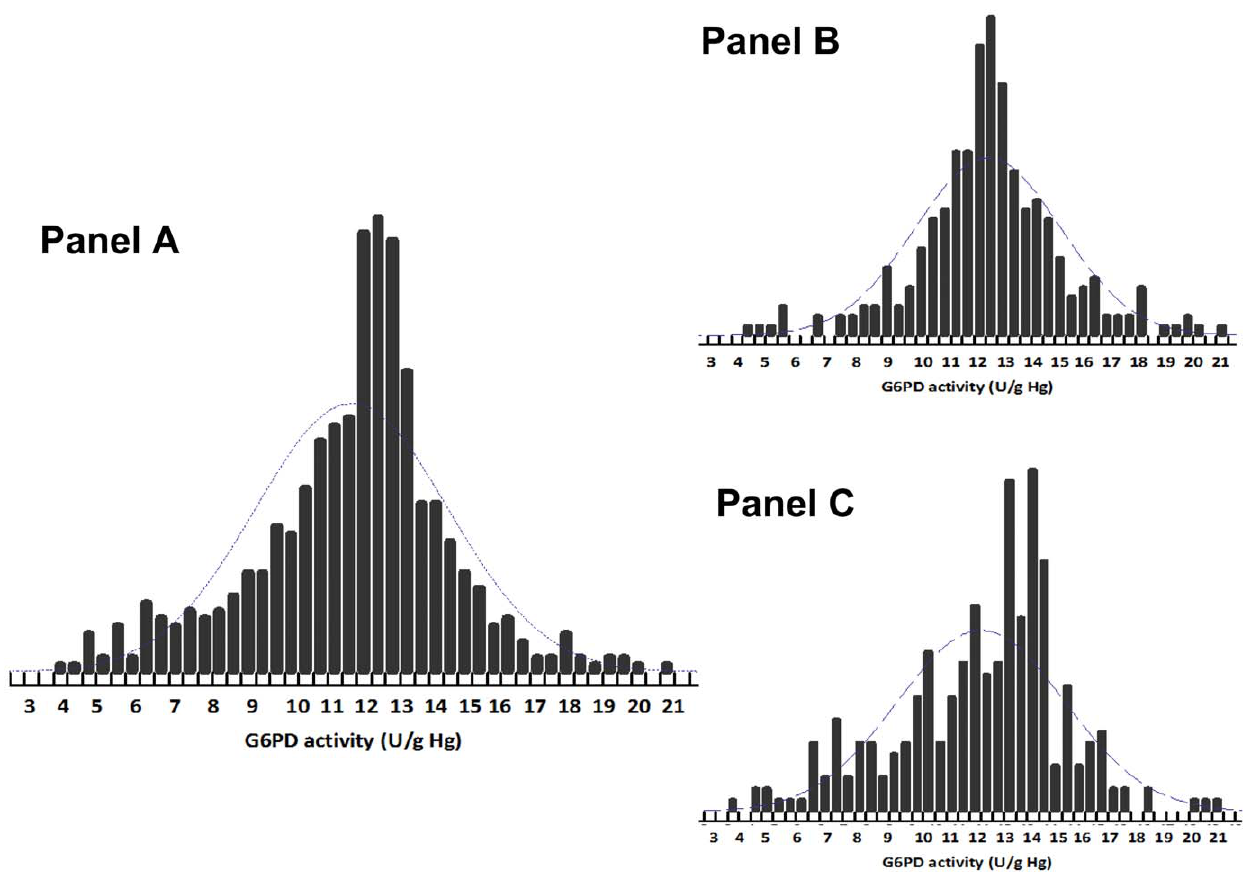
Figure 4. Distribution of the G6PD enzymatic activity (U/g Hb) reference values according to gender, of 147 G6PD-normal individuals (see criteria in Statistical analysis section) enrolled in four villages of the Pailin province, Cambodia, 2010. (Panel A: Total population, Panel B: Male population and Panel C: Female population). doi:10.1371/journal.pone.0028357.g004 PLoS ONE |